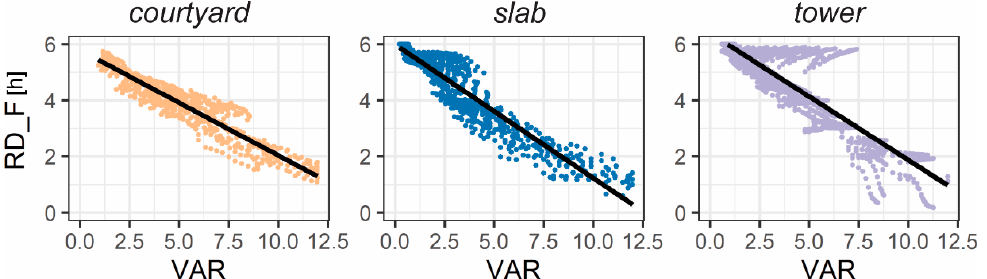
Figure 19. Linear regression functions of metrics VAR and RD_F based on neighbourhood iterations (black line), presenting results for each neighbourhood typology in a separate graph.